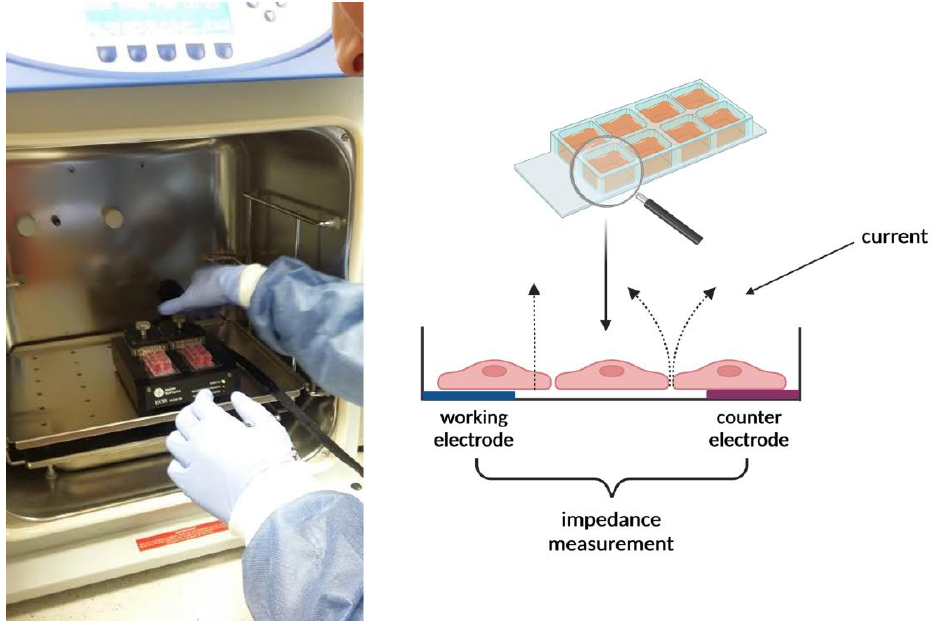
Figure 1. ECIS measuring station in the incubator (photo from the cell culture laboratory, Chair, and Department of Human Physiology, Medical University of Lublin). The scheme was created with BioRender